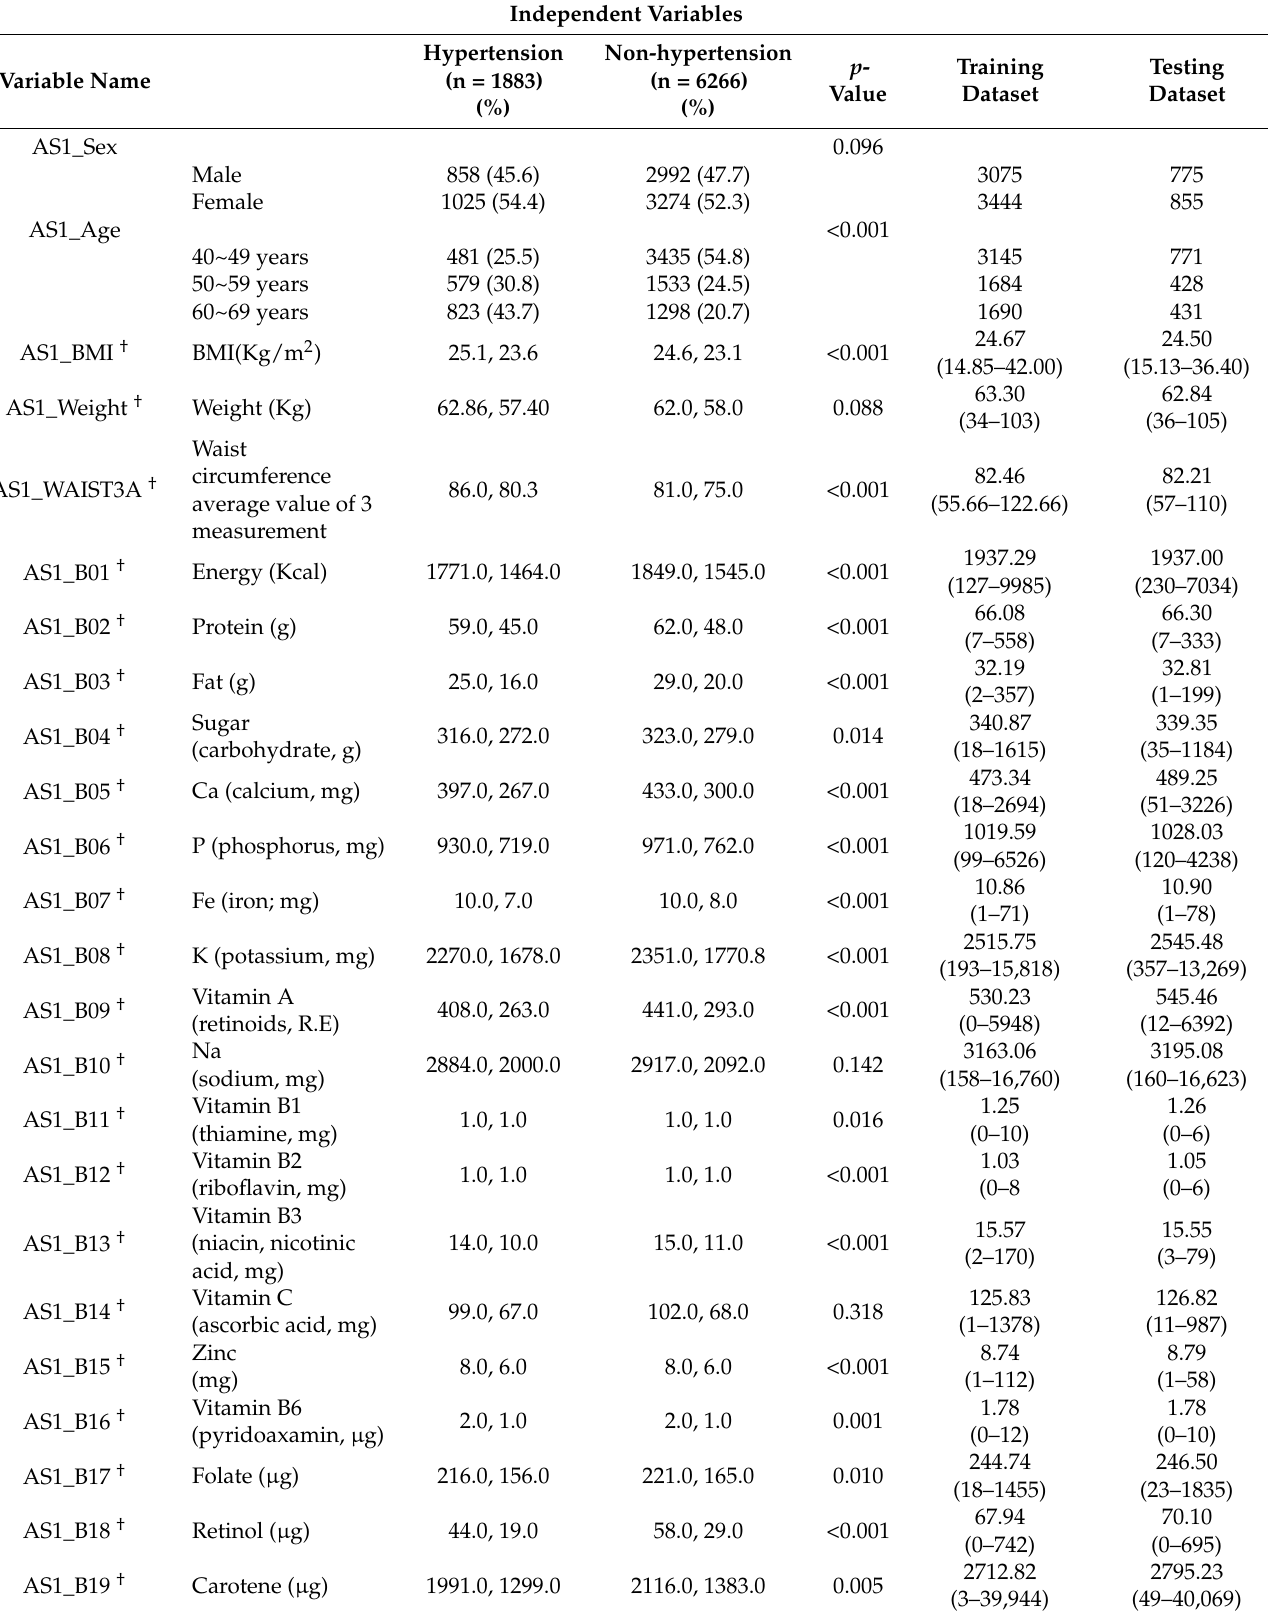
Table 5. Baseline characteristics of independent